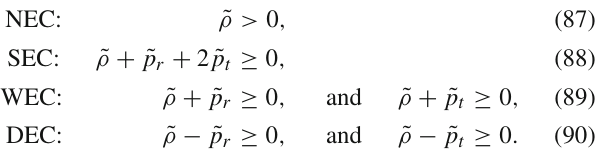
Fig. 2 The figures show the evolution of the parameters { ˜ ρ, ˜ p r , ˜ p t } versus the radial coordinate for the third model. We have added the RN case for comparison. To show the impact of the parameter α , we eval- uate the functions for three different values of the anisotropic coupling α plus the RN solution i.e.: (i) α = 0 for the RN solution (solid black